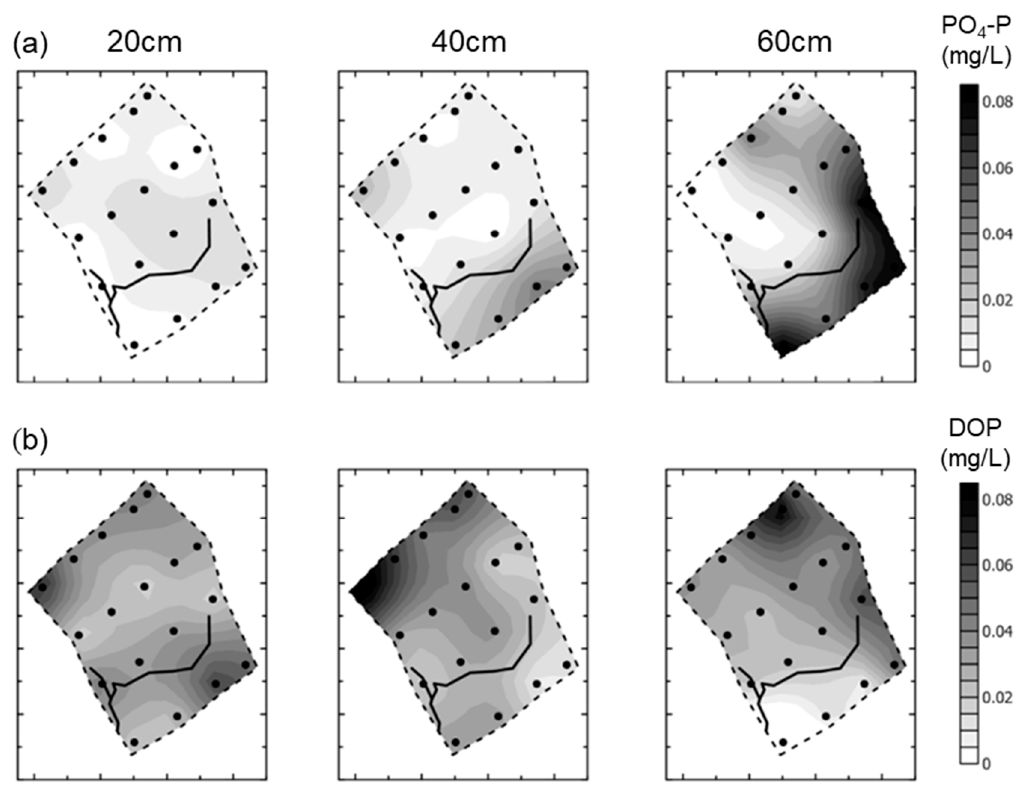
Figure 8. Soil porewater P fractionation under baseflow conditions (3 August 2004). Sampler locations are shown as black dots, as detailed in Figure 2. ( a ) shows PO 4 -P concentrations across the wetland at 20, 40 and 60 cm depth, while ( b ) shows DOP concentrations across the site at these same depths.